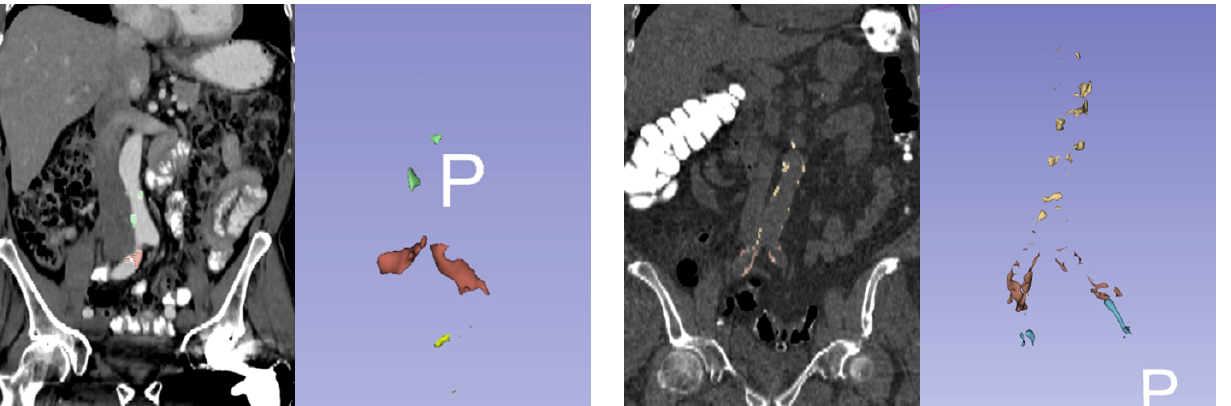
Figure 2. Example of Agatston score measurement. ( left ) A 72-year-old male with prostate cancer. Agatston scores for abdominal aorta (AA), common iliac arteries (CIA), and internal iliac arteries (IIA) were 752, 3932, and 506. ( right ) A 74-year-old asymptomatic male from the control group. Agatston score for AA, CIA, and IIA were 2814, 3265, and 1555. Plaques in AA, CIA, and IIA are colored differently. 3D images are facing anterior to posterior (P).